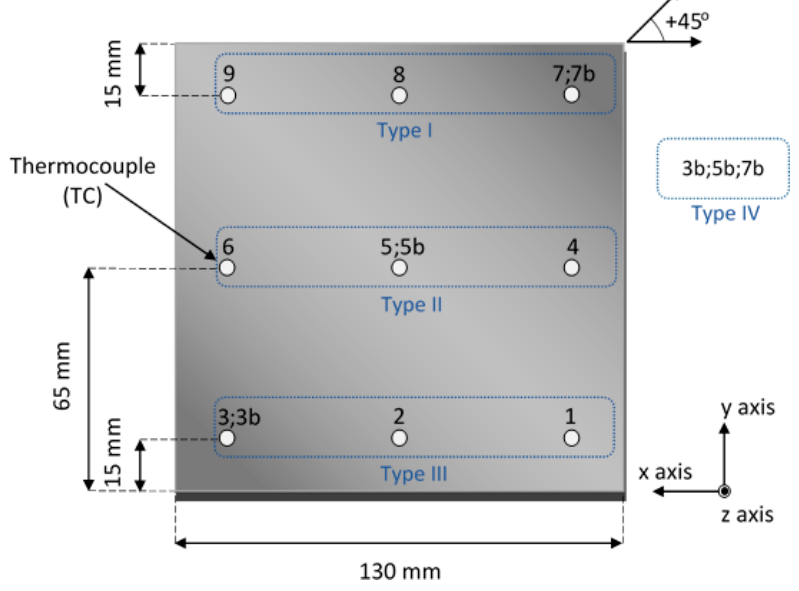
Figure 1. Schematic representation of thermocouples’ locations within the middle-plane of the square plate specimen.